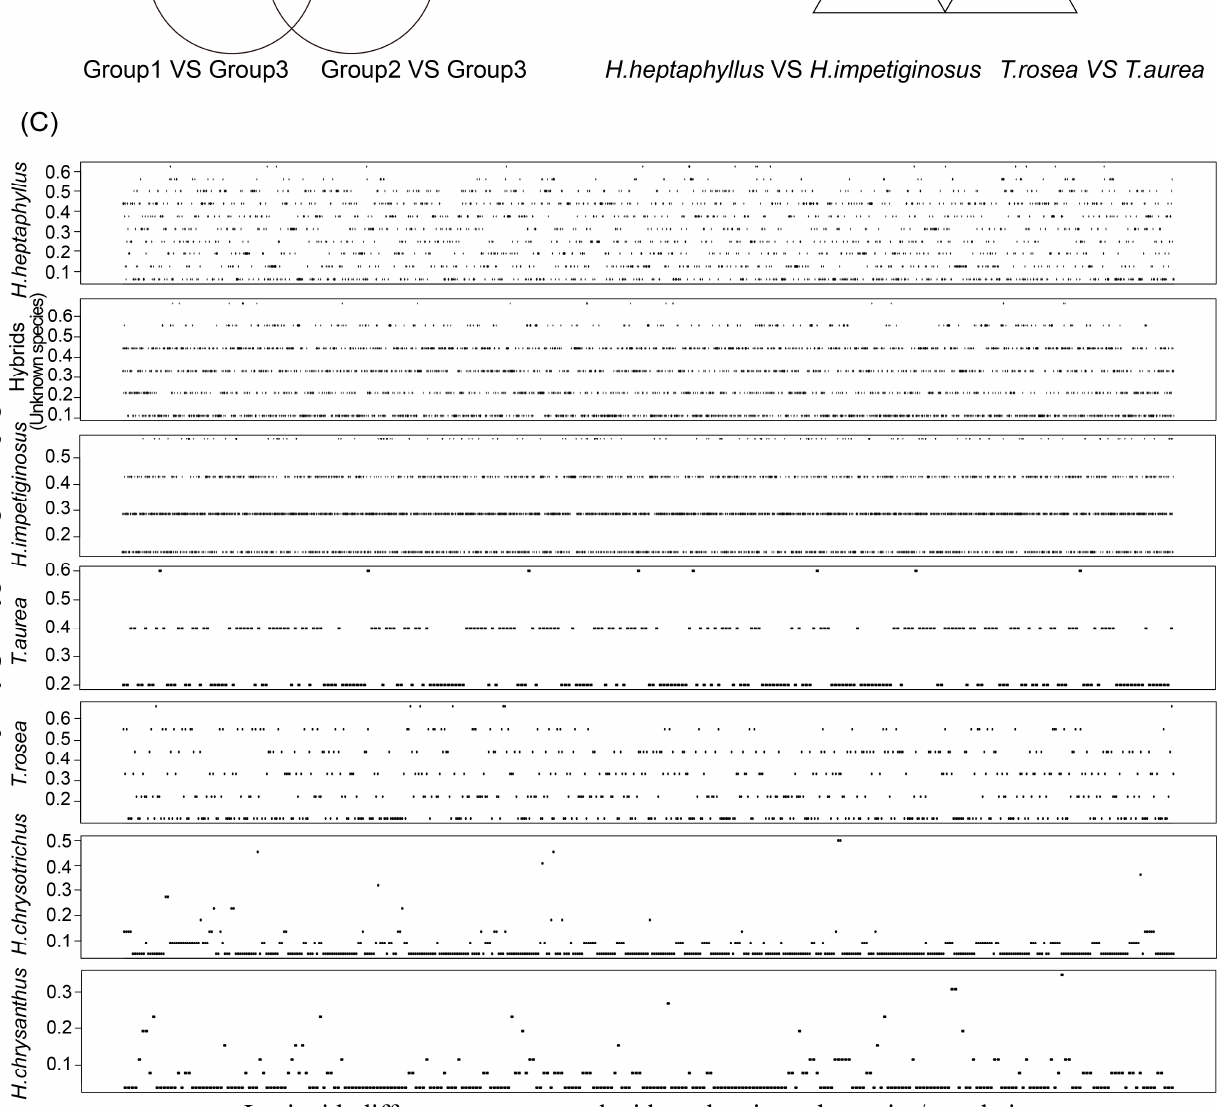
Figure 4. High-quality loci could be used for fingerprint construction. ( A ) The number of selected loci available to distinguish different groups; ( B ) The number of selected loci available to distinguish different species; ( C ) Description of polymorphic loci available to genetic study within each species.